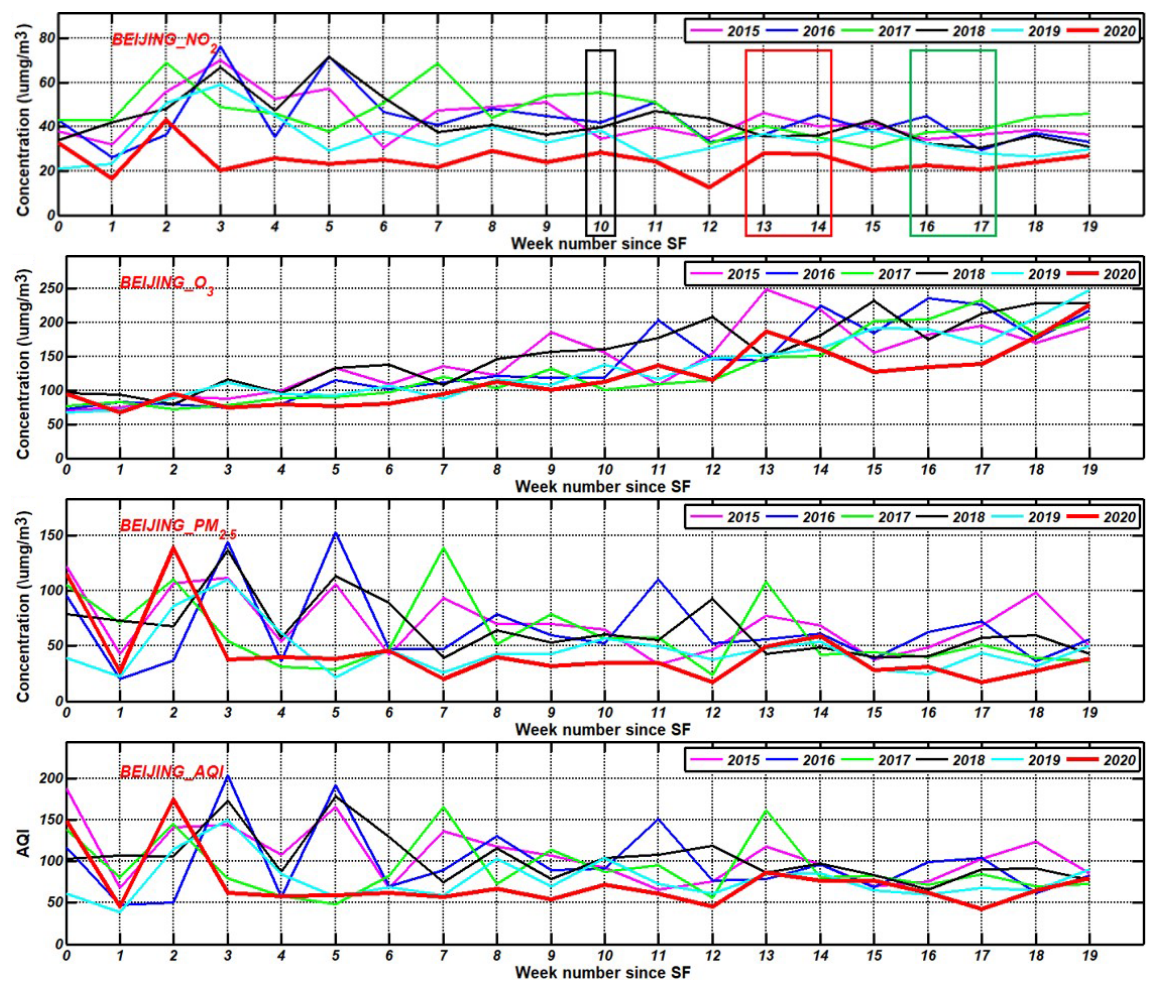
Figure 10. As Fig. 6 but for Beijing and from week 0 to week 19.